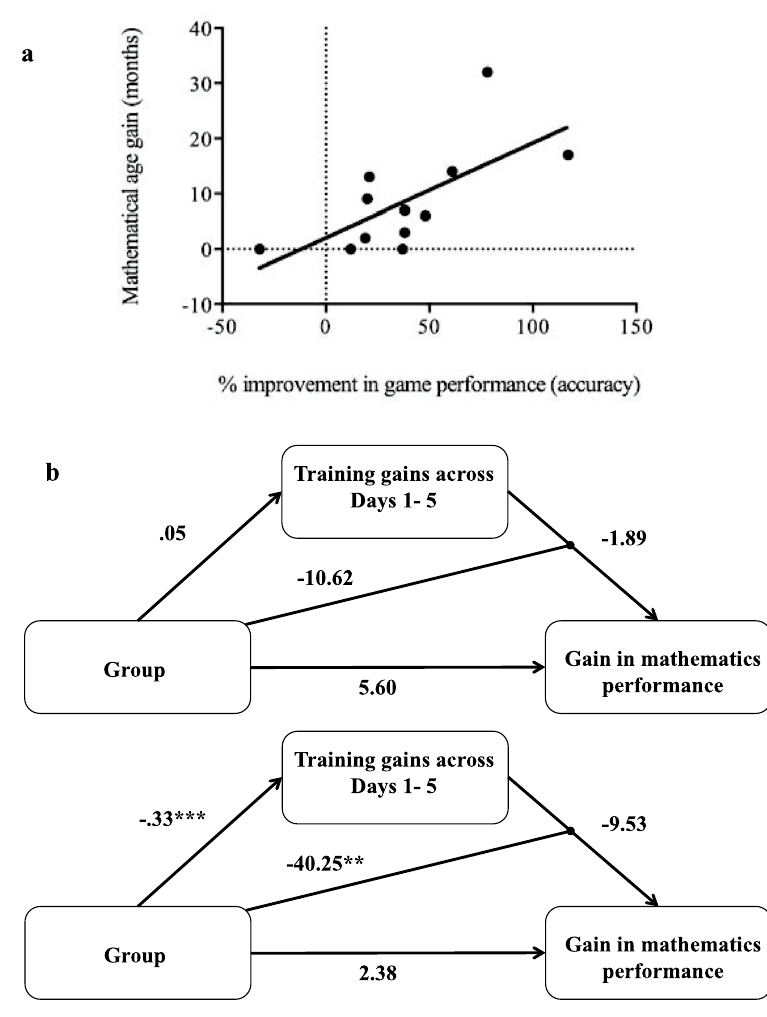
Figure 5. Transfer of training gains to real-life achievement ( a ) Improvement in training transferred to performance on a standardised diagnostic mathematics test (MALT), a measure of achievement at school. Note that while we presented the actual values, the correlation was calculated using rank data (Spearman correlation) to account for the sample size and to avoid spurious results due to outliers. These points are not labelled by groups, as we found no effect of group. ( b ) Model 1 shows the non-significant effect of tRNS on training across Days 1 to 5 and gain in maths performance as indicated by the MALT (mathematical age-equivalence). Model 2 presents the significant relationship between gains in accuracy across Days 6 to 9 and gain in maths performance as indicated by the MALT (mathematical age-equivalence), which was moderated by group (tRNS vs. sham). Models 1 and 2 demonstrate the influence of tRNS on transfer, which depend on its effect on cognitive training. For the sake of transparency, we presented the unstandardised regression coefficients in the figure, and reported the corresponding beta weights in the text. ** = p < 0.02, *** = p <